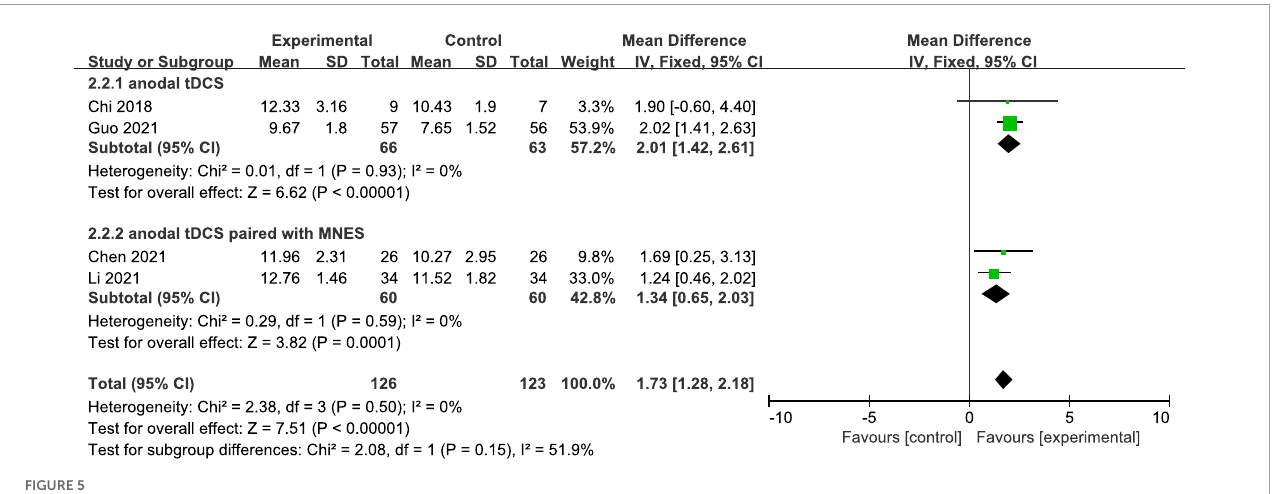
FIGURE5 Subgroup analysis of stimulation protocol on GCS socres in patients with